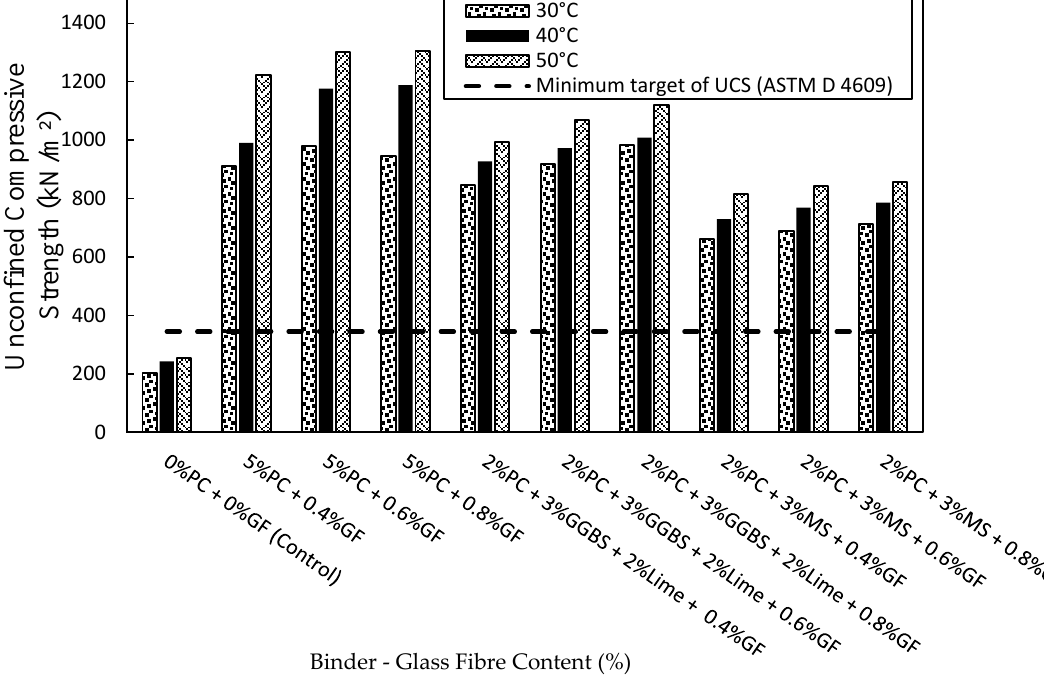
Figure 7. UCS of glass fibre-reinforced clay-binder mixtures tested immediately after ET curing.